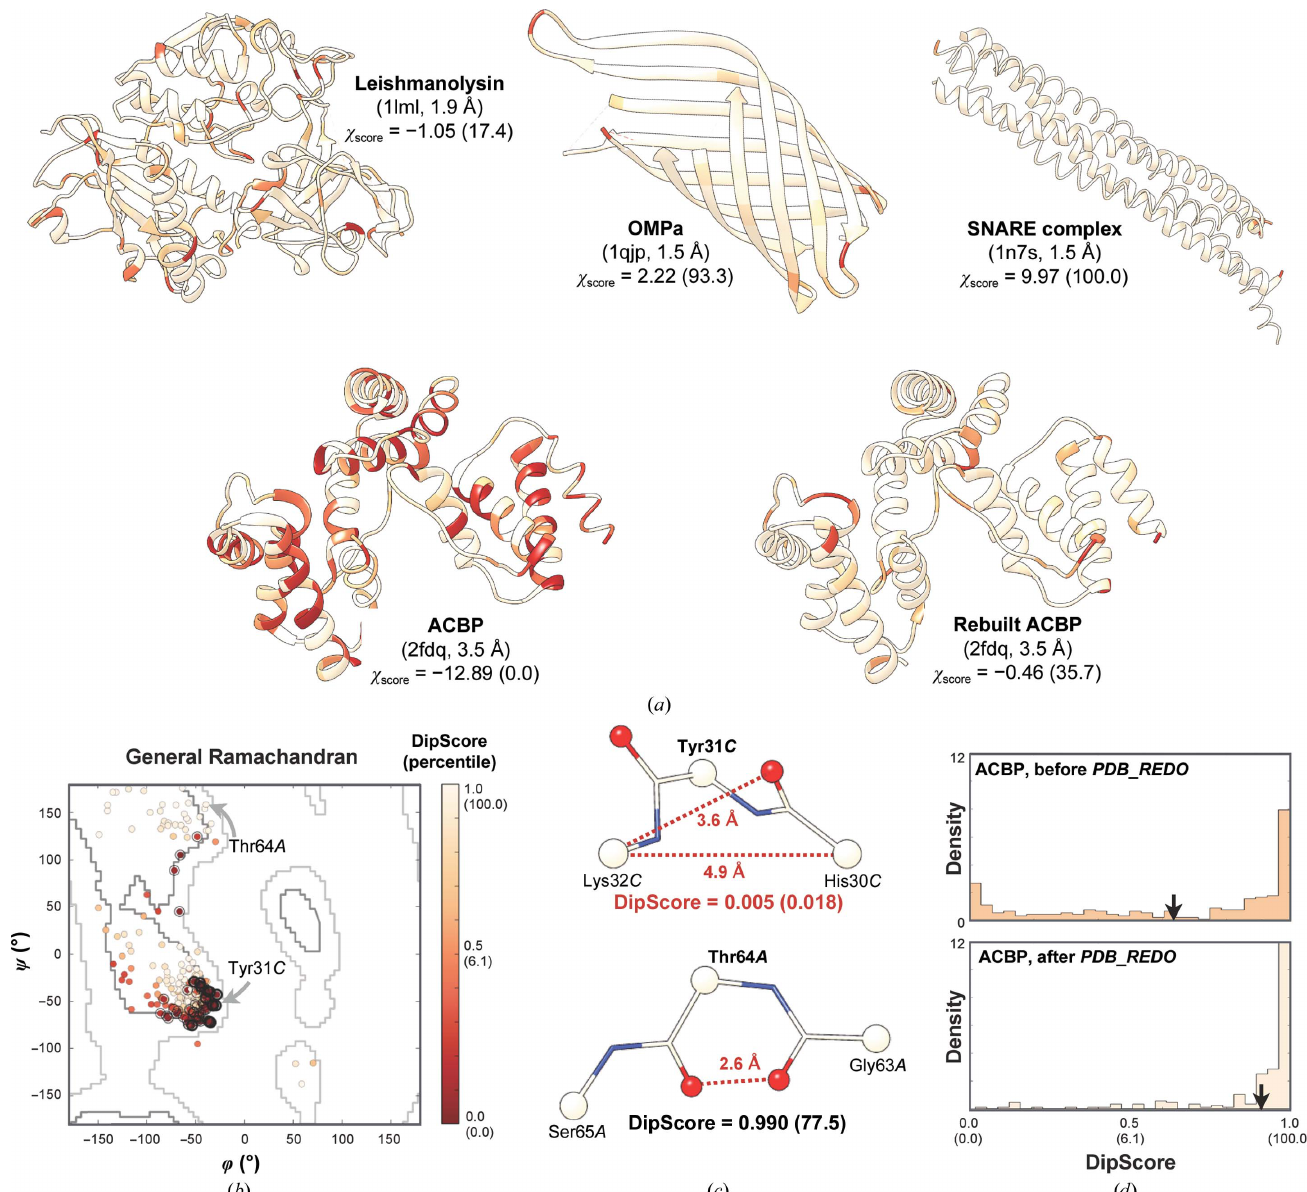
Figure 5 Local and overall protein model validation using the DipSpace. Values in parentheses indicate the corresponding percentiles. ( a ) Cartoon representation of the test cases, coloured by their local DipScore. The PDB codes and resolutions of the models are indicated. ( b ) General (nonglycine/nonproline) Ramachandran plot for the ACBP model. The allowed (grey) and favoured (dark grey) boundaries according to Lovell et al. (2003) are marked. Outliers (DipScore < 0.010; percentile < 0.05) are surrounded by a black circle and those in allowed and generously allowed regions (DipScore between 0.010 and 0.240; percentile between 0.05 and 2.0) by a light grey circle. ( c ) Ball-and-stick representation of ACBP Tyr31 C and Thr64 A dipeptide units, highlighting their DipScore and problematic distances. ( d ) DipScore histograms for the ACBP models. Arrows mark the average DipScore for the